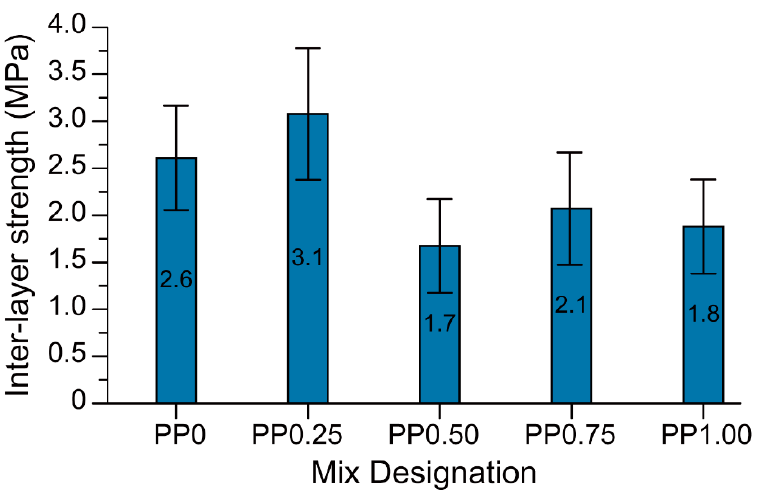
Figure 12. The interlayer bond strength of 3D-printed specimens.